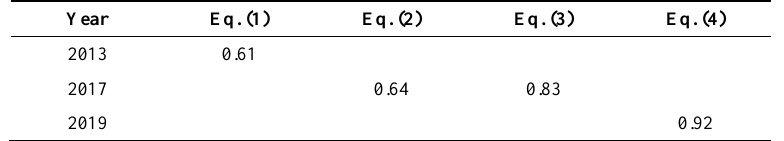
Table 4. Summary of potential Colour Naturalness formulae with quoted (or deduced) values for r